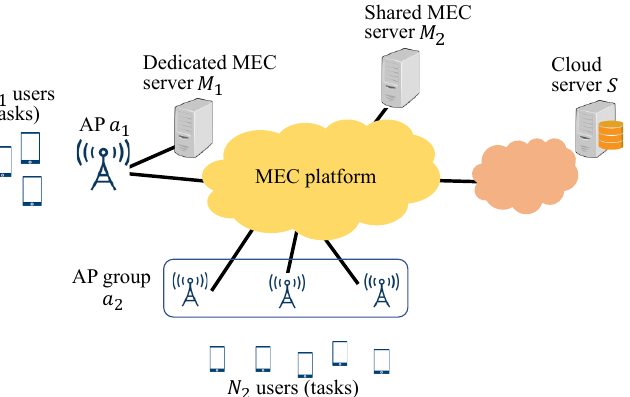
Figure 1. System model consisting of a MEC platform with three types of servers.